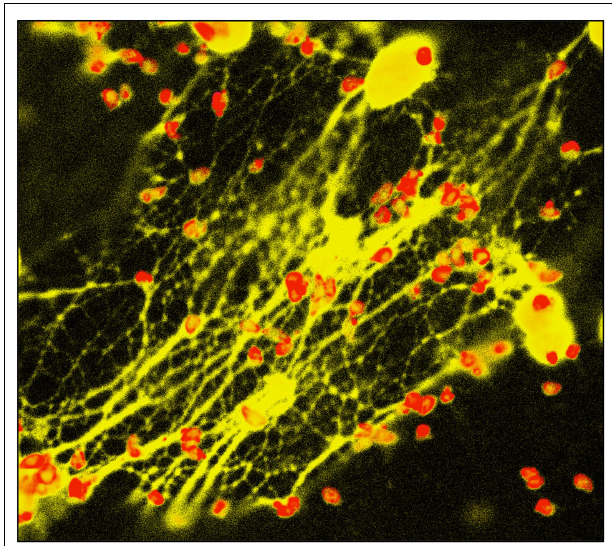
FIGURE 2 | NET formation triggered by Toxoplasma . Human peripheral blood neutrophils were co-incubated with Toxoplasma in the presence of cytochalasin D to prevent invasion. 4 hrs later, cells were fixed and stained with antibody to the tachyzoite surface molecule SAG-1 (pseudo-colored red). PMN nuclei and NETs were visualized using DAPI (pseudo-colored